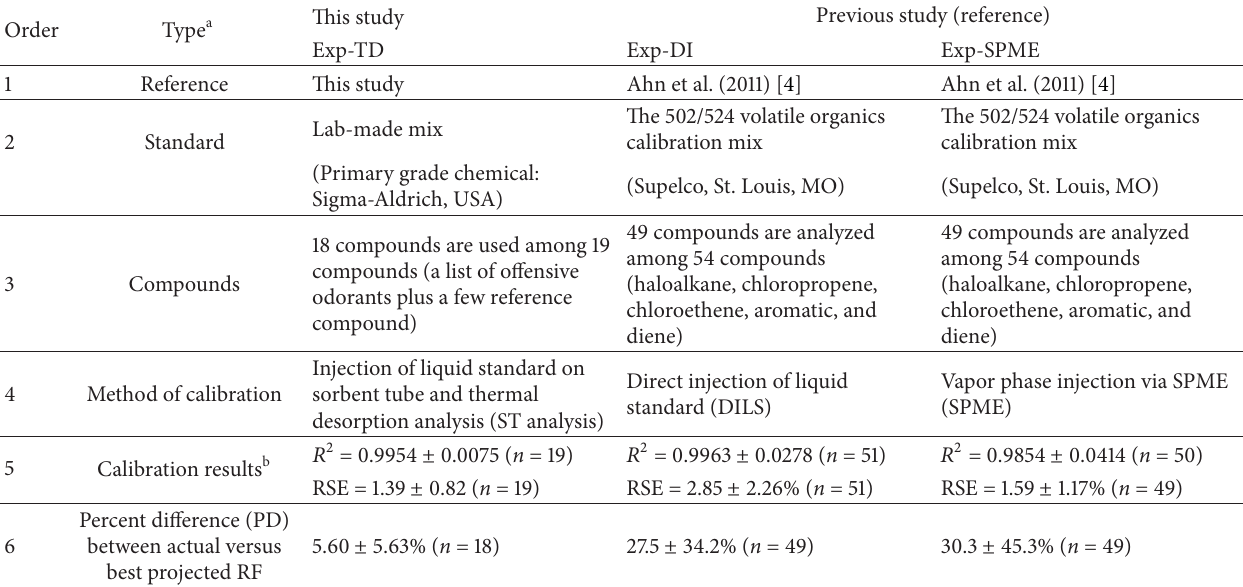
Table 1: Conceptual schematic of experimental (Exp) approaches to estimate response factor (RF) values of compounds lacking authentic standards/surrogates (CLASS).